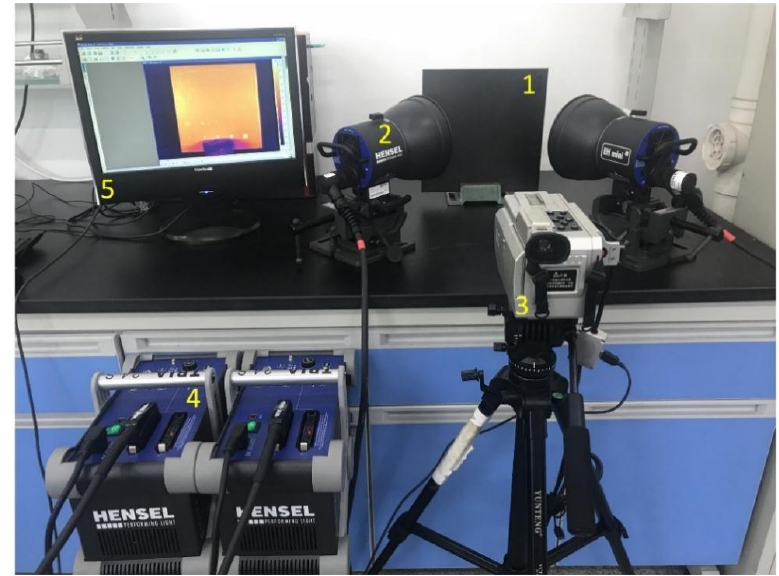
Figure 5. PT inspection equipment. 1-Specimen; 2-flash lamp; 3-infrared thermal imager; 4-high power generator; 5-computer.